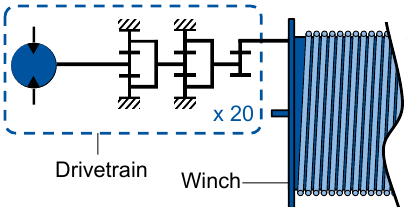
Figure 4: Simplified schematic of winch drum and driv- etrain analysed (Wll et al., 2017b)